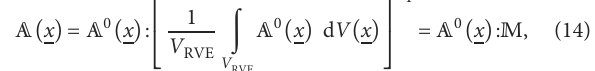
distribution 𝕔( x ) , spreading throughout an infinite domain, see Figure 1C . The stiffness distribution is considered as